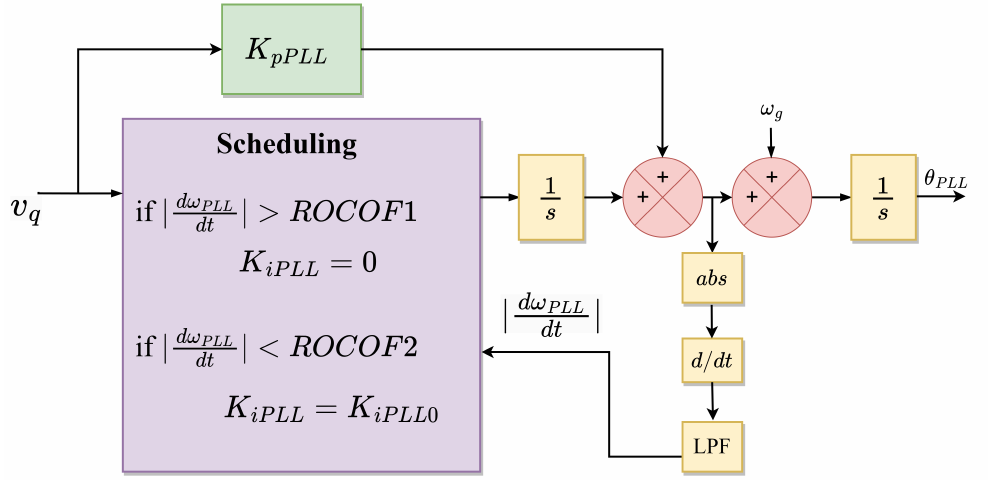
Figure 17. Approach 4